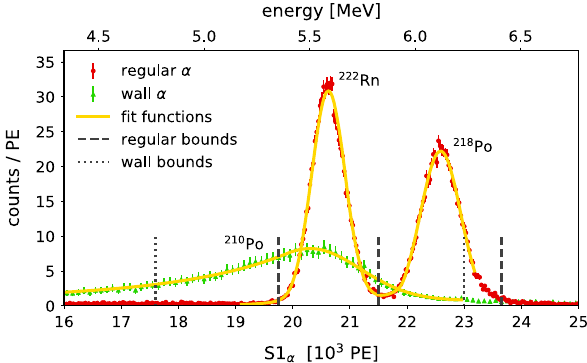
Fig. 2 Corrected S1 α spectra (SR1). The left peak of the regular α selection spectrum (red, circular markers) is attributed to 222 Rn, the right one to 218 Po, with their bounds (3 σ intervals) indicated by dashed lines. The tailing peak in the wall selection spectrum (green, triangular markers) is considered to belong to 210 Po and has its bounds indicated by dotted